Question: Briefly state, in one sentence, what is plotted here.
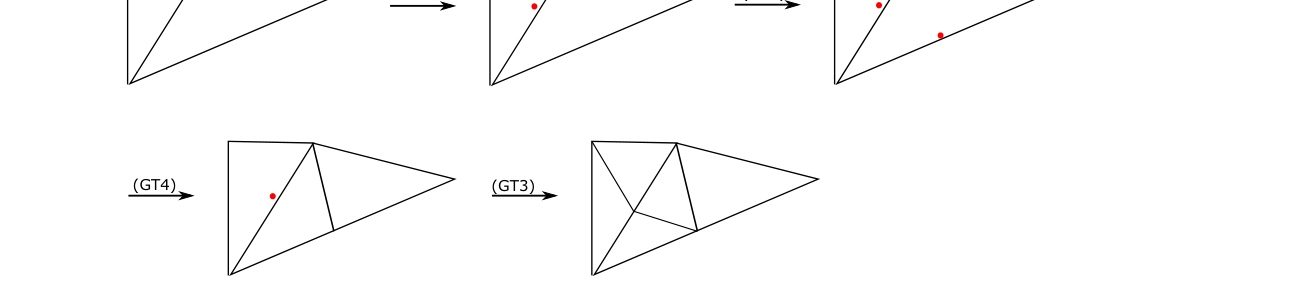
Answer: The process of Rivara refinement algorithm for the simple two element mesh in the case the left element should be refined.